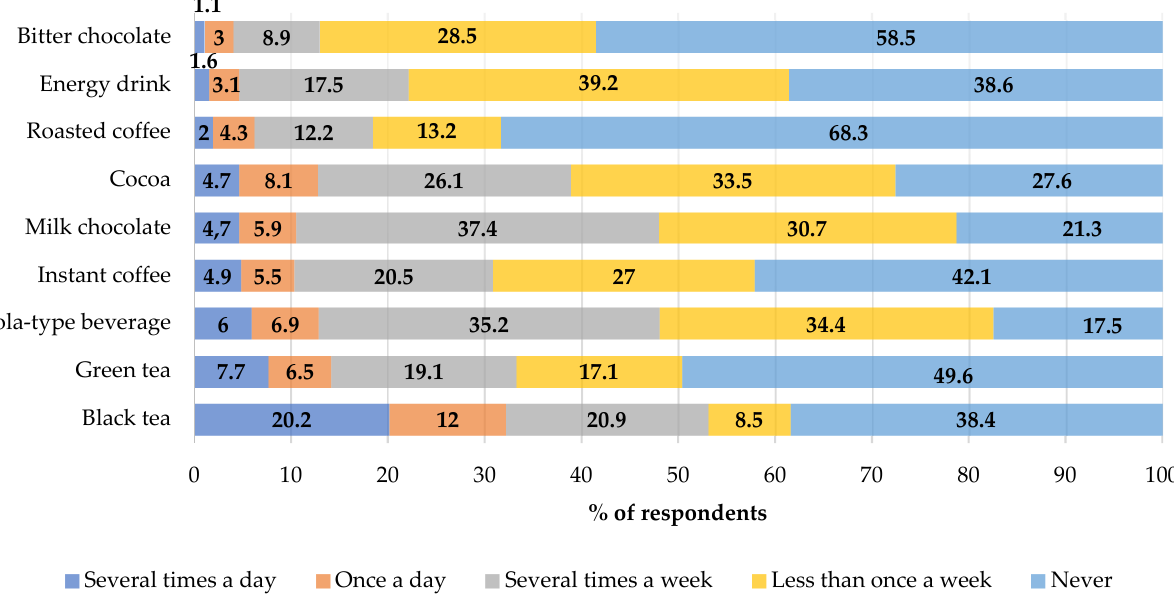
Figure 1. Frequency of the consumption of selected caffeine source products in the total study group (%). Boys drank significantly more often cola-based soft drinks (24.8% vs. 17.6%; p = 0.0401) and ate bitter chocolate than girls (31.7% vs. 25.6% p = 0.0219) per week. The weekly consumption of instant coffee was significantly more common in girls than in boys